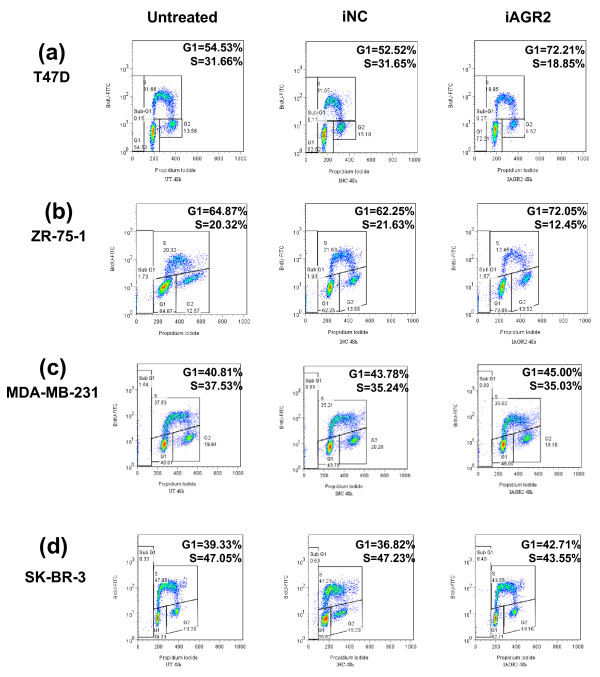
AGR2 knockdown reduces cell proliferation in ER-positive breast cancer cells. Cell-cycle profiles were analyzed with BrdU incorporation. Cells were pulse-labeled with 10 μM BrdU 48 hours after transfection and analyzed for BrdU incorporation with FACS. Cells were gated on Sub G1, G0/G1, S, and G2/M populations. (a) T47 D, (b) ZR-75-1, (c) MDA-MB-231, and (d) SK-BR-3 cells.